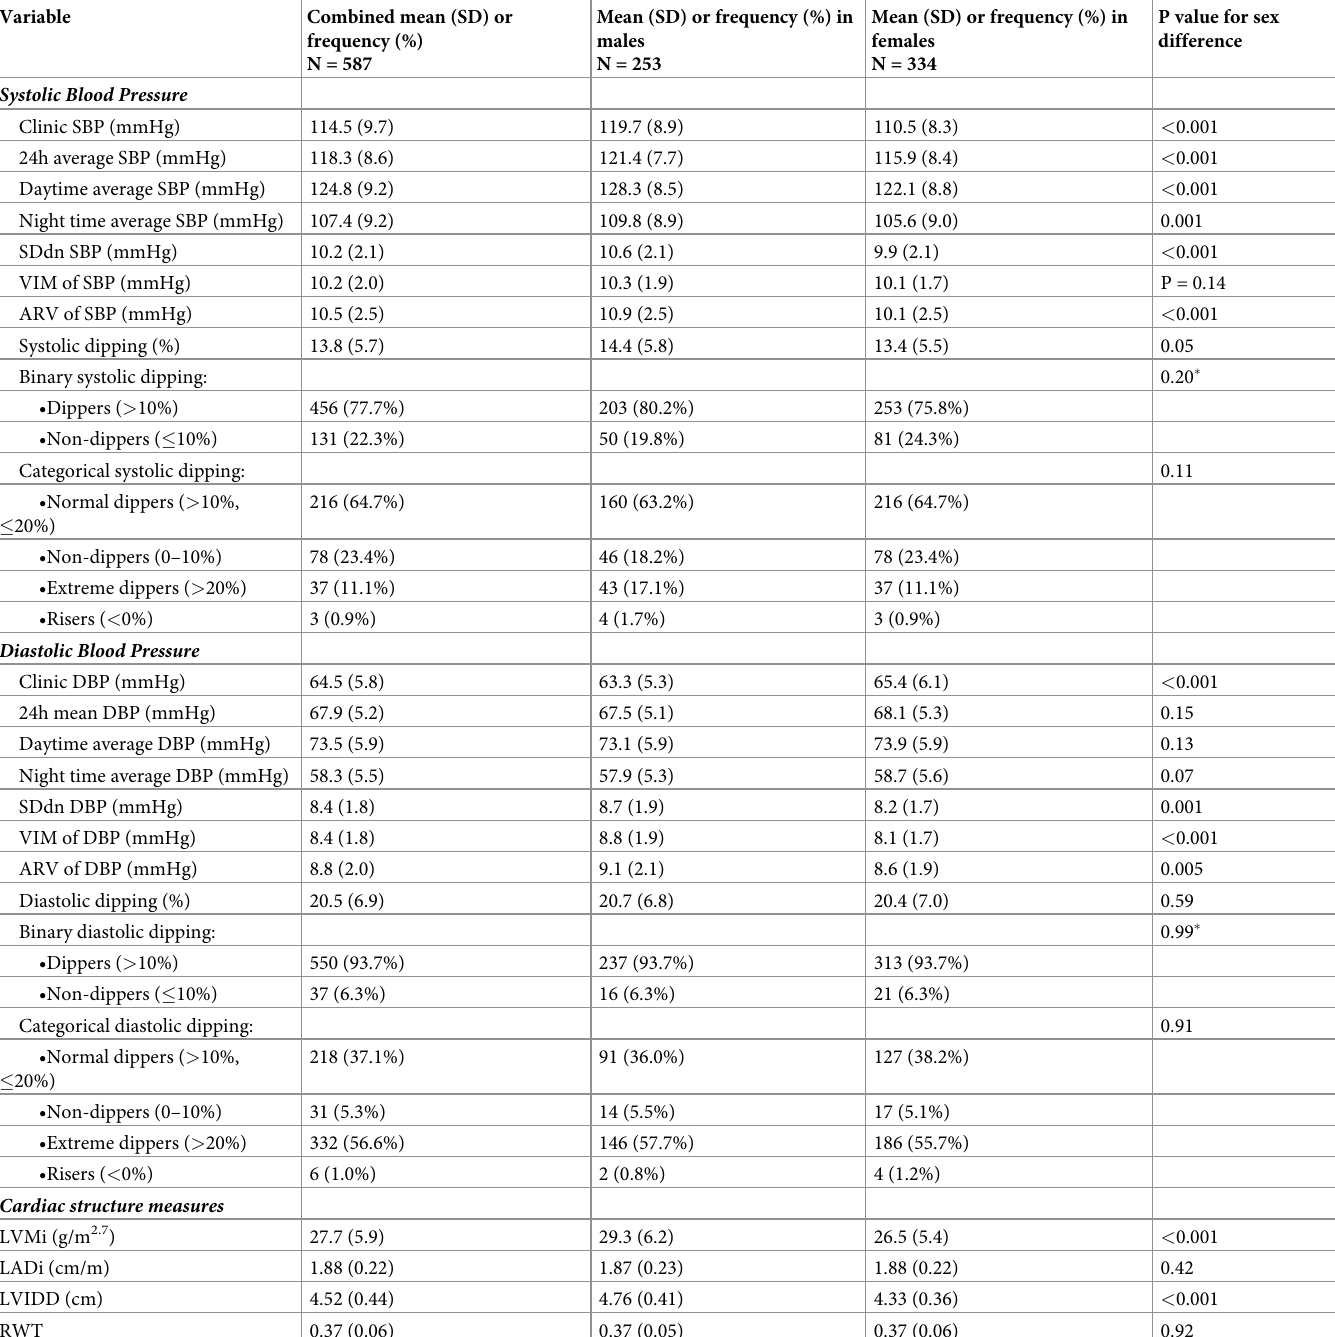
Table 1. Measures of blood pressure and cardiac structure for participants included in the analysis, N =